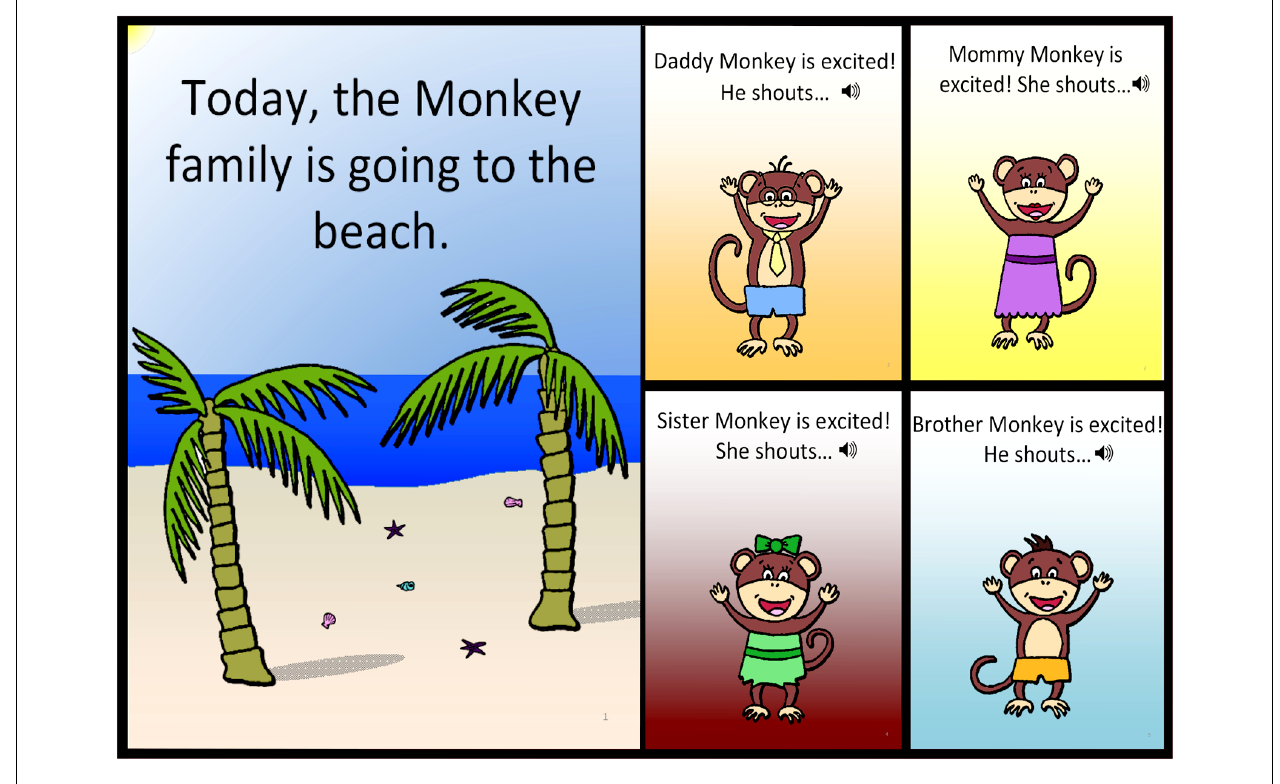
monkey character in the story (either Daddy, Mommy, Sister or Brother Monkey), and the monkey characters were presented in the same order six times throughout the book. A sample of the storybook and CD can be found at: http://psycserv.mcmaster.ca/